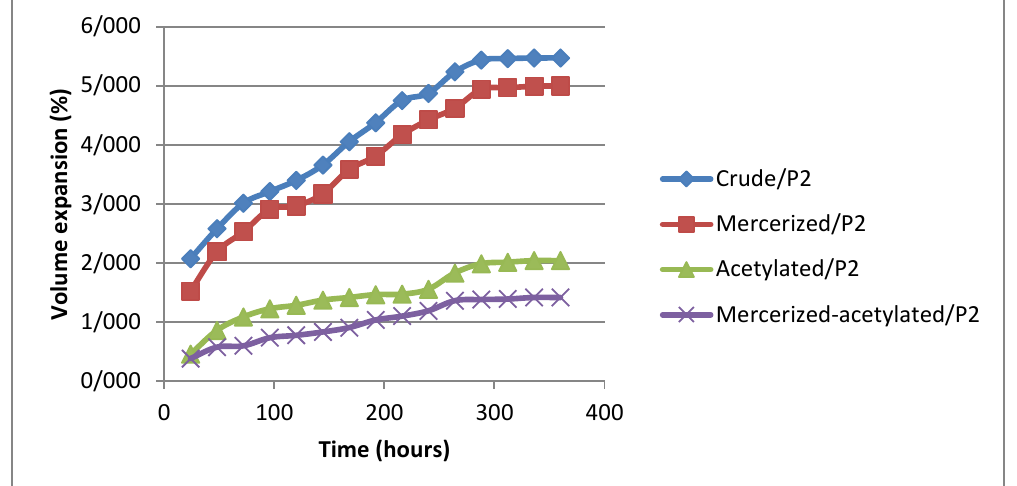
Fig. 20. Volume expansion due to moisture absorption at P3 fibre content